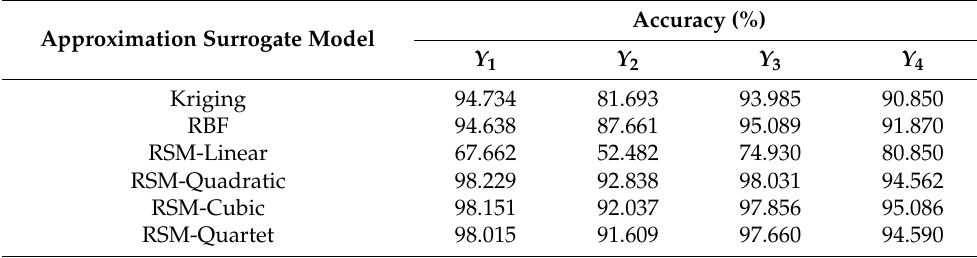
Table 6. The accuracy of the Kriging models, RBF models, and the RSM-Linear, RSM-Quadratic, RSM-Cubic and RSM-Quartet